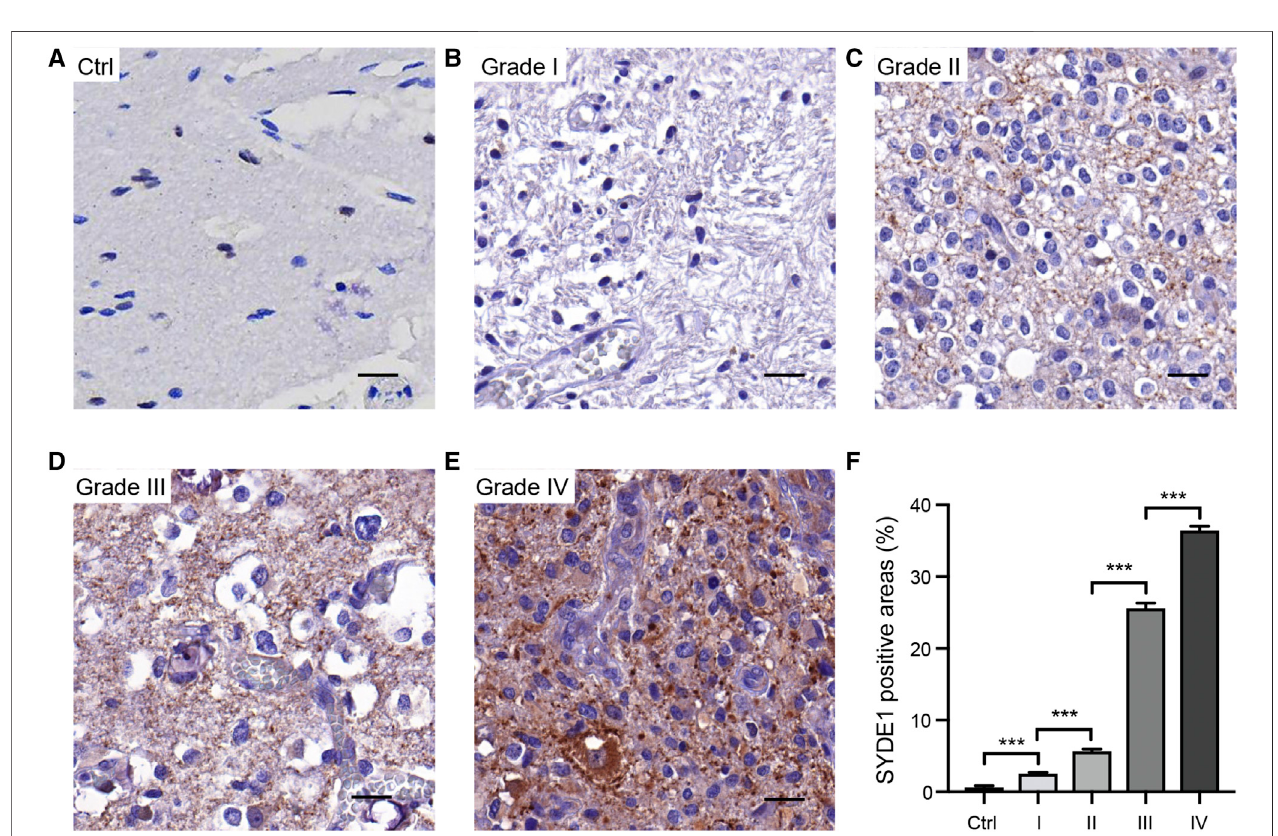
FIGURE 5 | Immunohistochemical analyses of SYDE1 expression in resection specimens of normal human brain and grade I to IV glioma. (A) Negative SYDE1 staining innormal human brain. (B – C) Weak SYDE1 staining in grade Iglioma (B) and grade II glioma (C) . (D – E) Strong SYDE1 staining ingrade III glioma (D) and grade IV glioma (E) . (F) Quanti fi cation of SYDE1 positive areas at A-E. ***, p.value < 0.001; Scale bars (cid:1) 25 μ